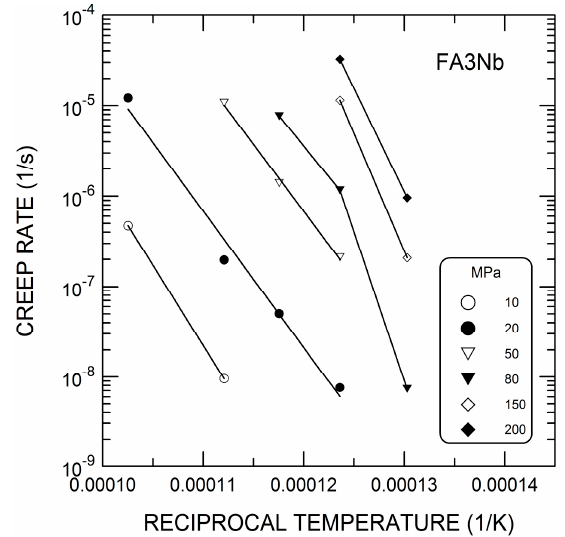
Figure 6. Dependence of minimum creep rate on reciprocal temperature for the alloy FA3Nb.